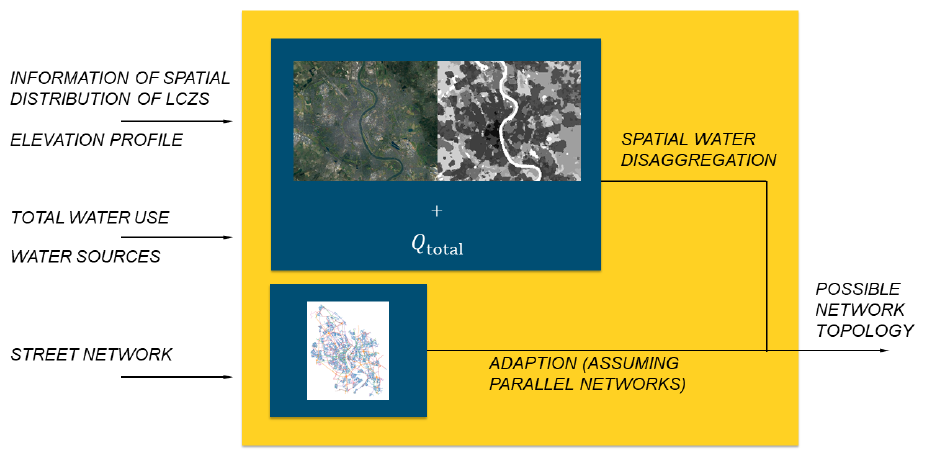
Figure 1. Framework used in this